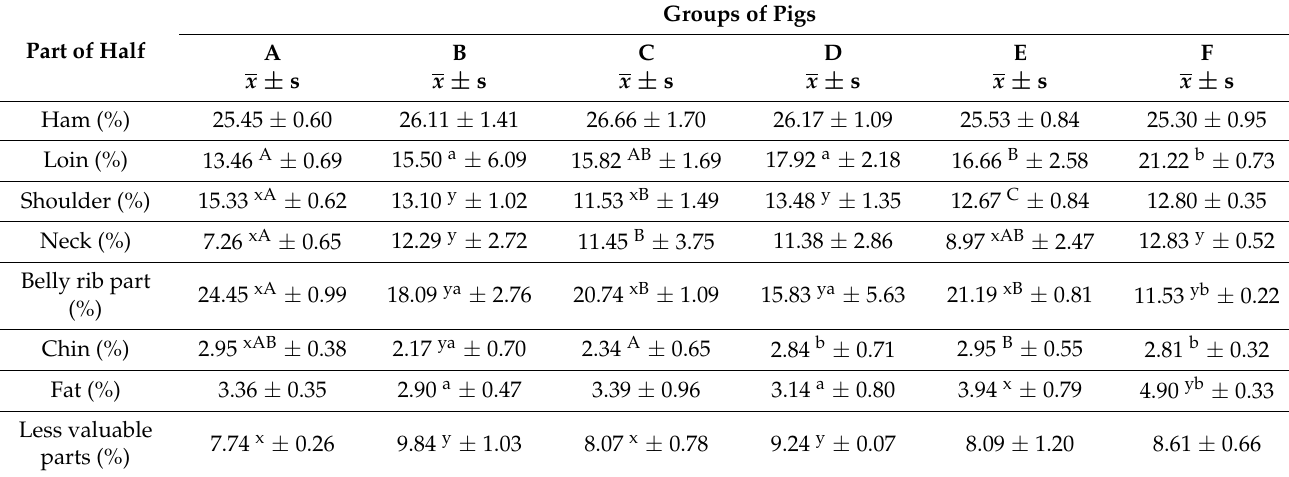
Table 4. Shares of the basic parts of the pig carcasses